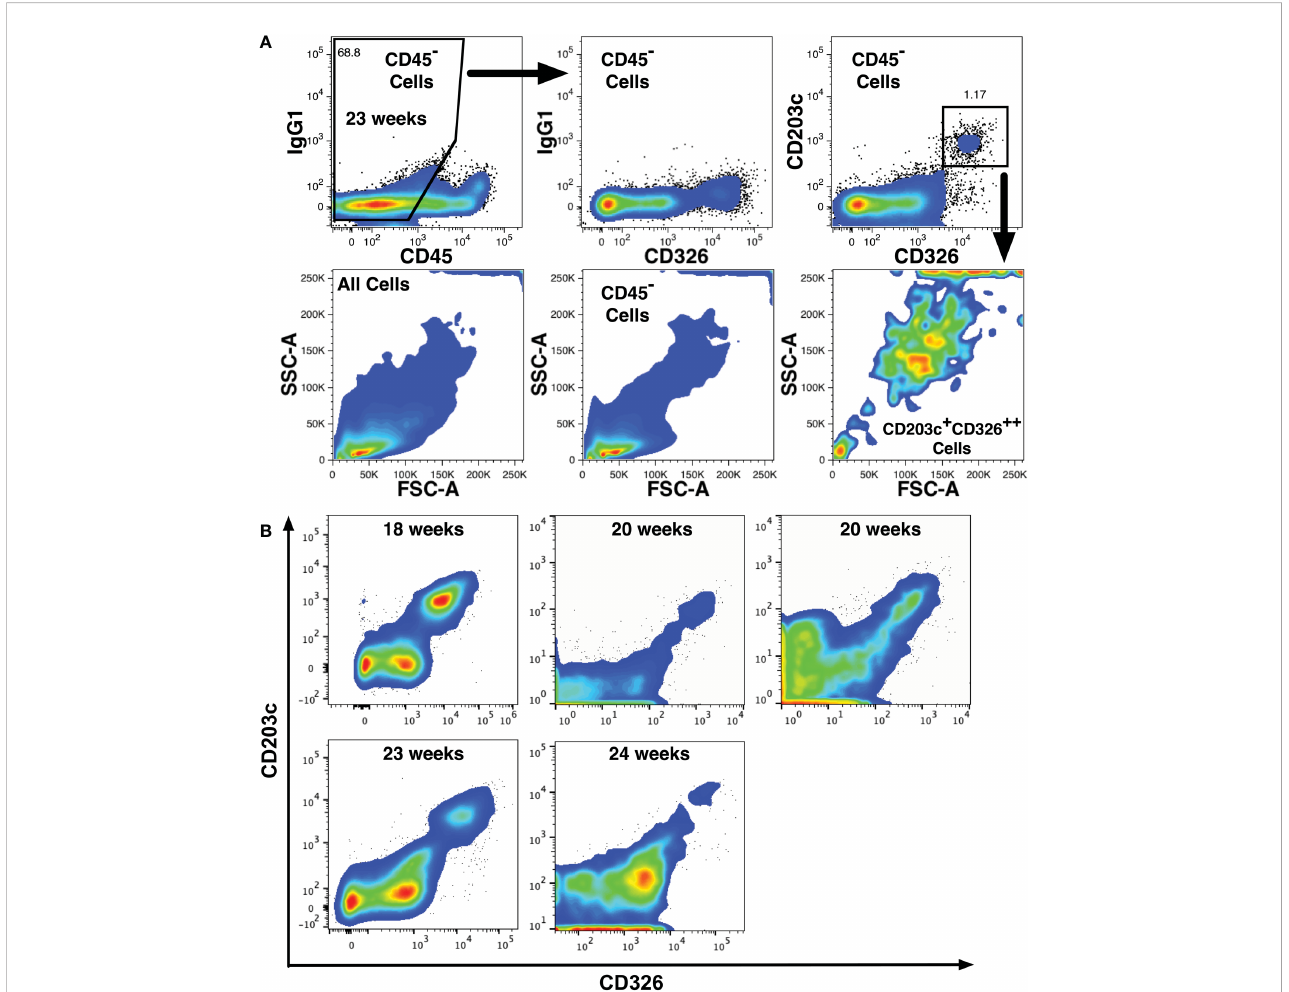
FIGURE 3 CD203c expression on fetal hepatoblasts. (A) CD203c expression by 23 weeks ’ gestation liver cells lacking CD45 expression but expressing high levels CD326 (CD326 ++ ). Light scatter properties of the cell populations shown in the top row are shown in the second row and indicate that CD203c + CD326 ++ cells are large and have a complex structure. (B) Expression of CD203c and CD326 on CD45 - liver cells at different gestational ages from 5 additional liver